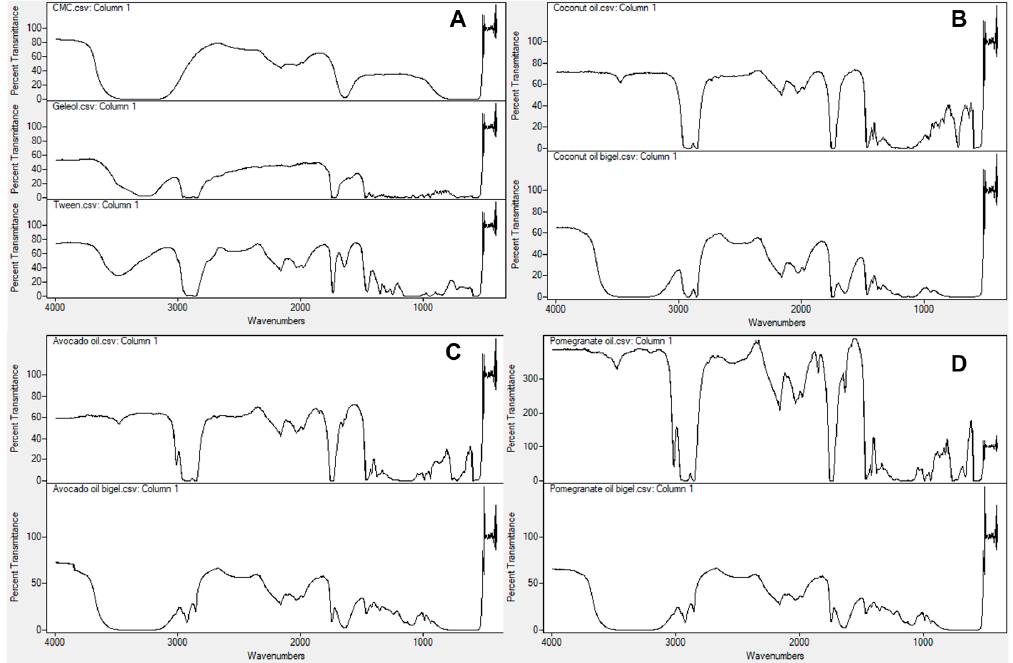
Figure 2. FTIR spectra of bigel formulation components: ( A ), coconut oil and corresponding bigel ( B ), avocado oil and their bigel, and ( C ), pomegranate oil and corresponding bigel ( D ).